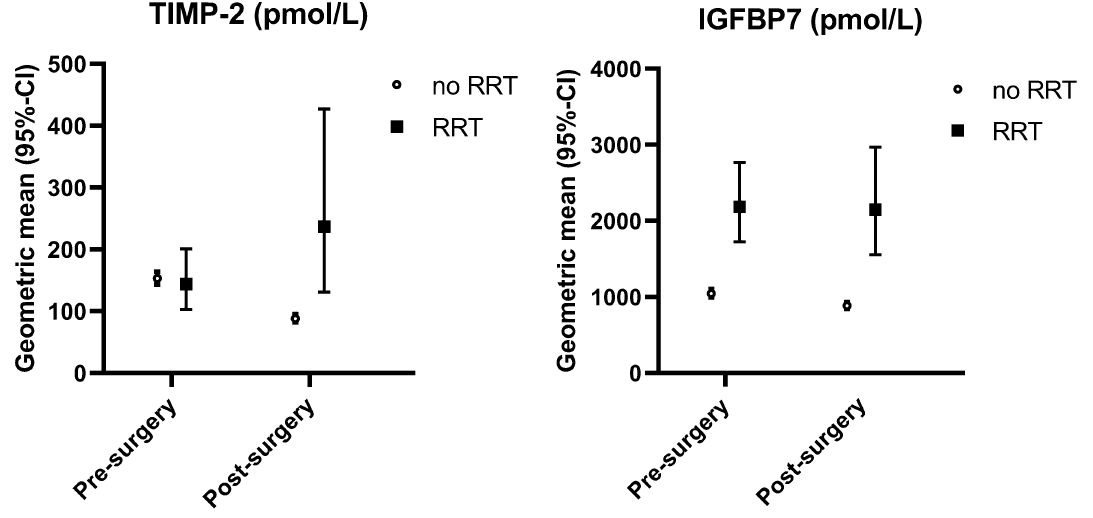
Figure 1. Urinary biomarker concentrations among cardiac patients, pre- and post-surgery according to need of renal replacement therapy. CI, confidence interval; IGFBP7, insulin-like growth factor-binding protein 7; RRT, renal replacement therapy; TIMP-2, tissue inhibitor of metalloprotease-2.